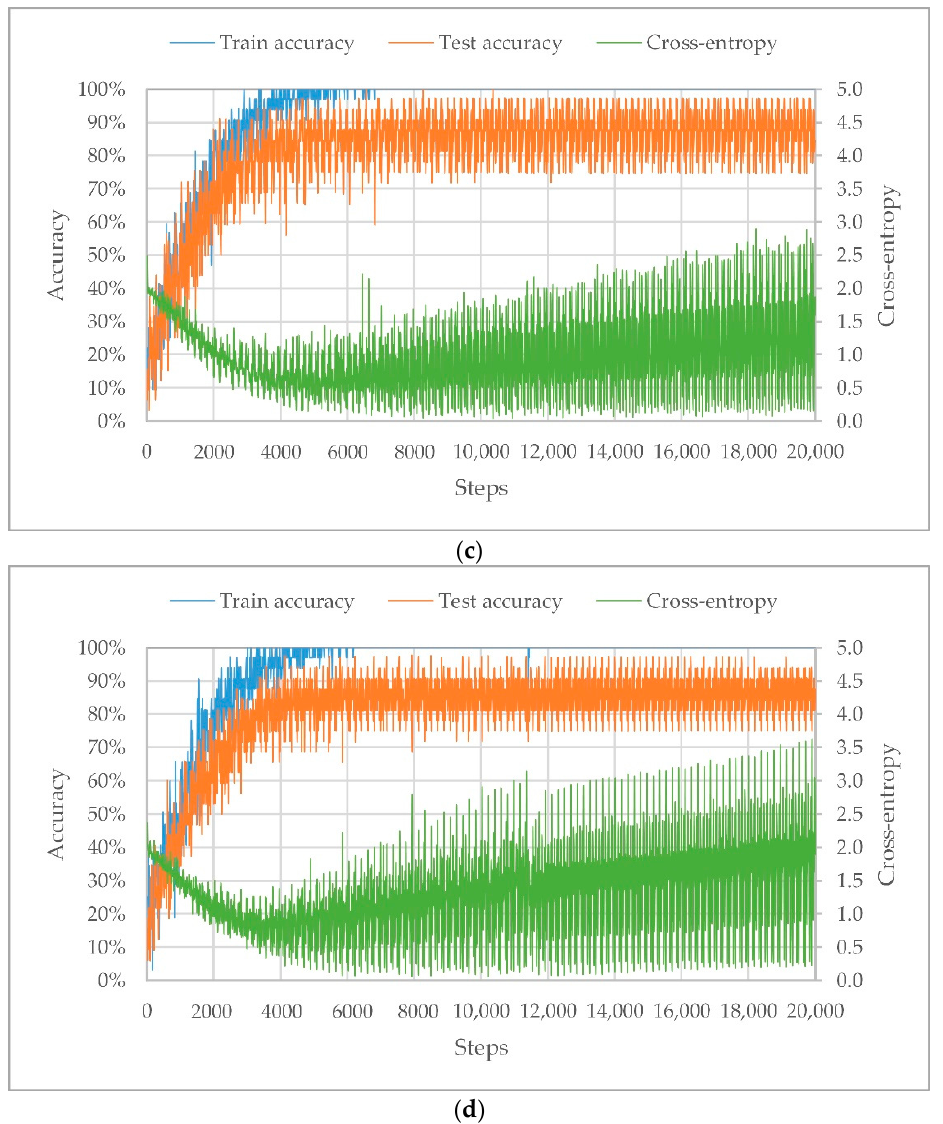
Figure 8. Train accuracy, validation accuracy and cross-entropy variation in the convolutional neural network (CNN) training process: ( a ) Two layers using color dataset; ( b ) Three layers using color dataset; ( c ) Four layers using color dataset; ( d ) Three layers using grayscale dataset.